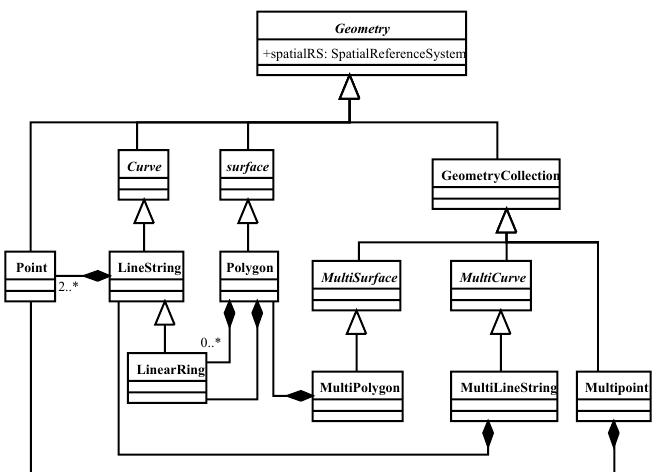
Figure 4. Geometric types in Open Geospatial Consortium (OGC)-simple feature access (SFA) implementation specification.